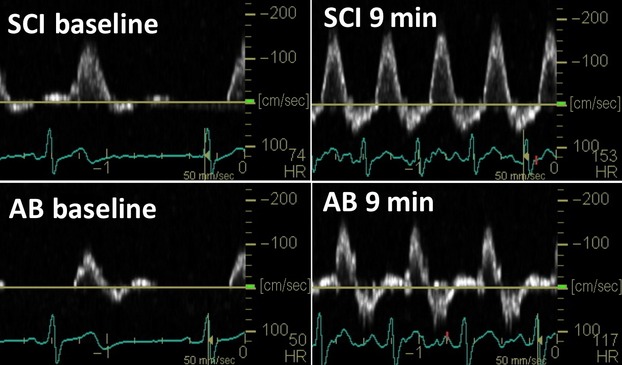
Arm-crank exercise intervention (Doppler Screen Capture). Superficial femoral artery blood velocity profiles at baseline and at 9-min of the arm-crank exercise intervention for an individual with spinal cord injury and an able-bodied control.